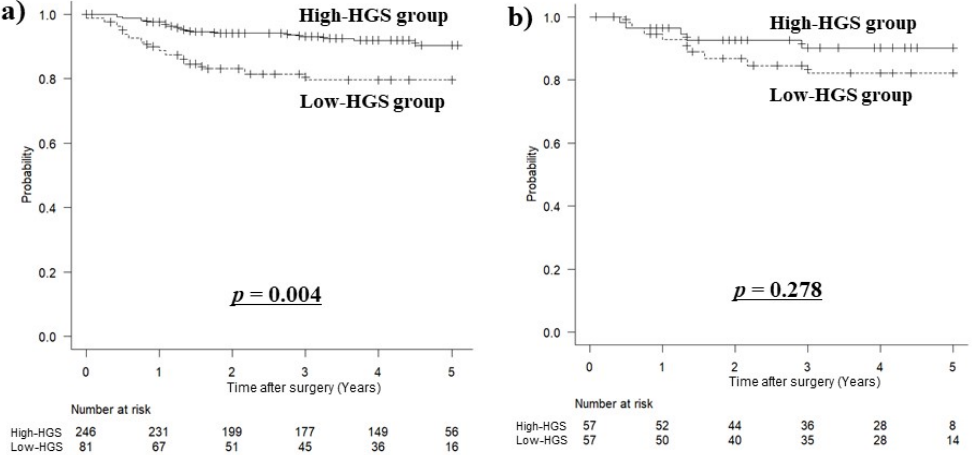
Figure 2. Kaplan–Meier survival curves for overall survival based on hand grip strength. ( a ) Be- fore matching ( p = 0.004) and ( b ) after matching ( p =